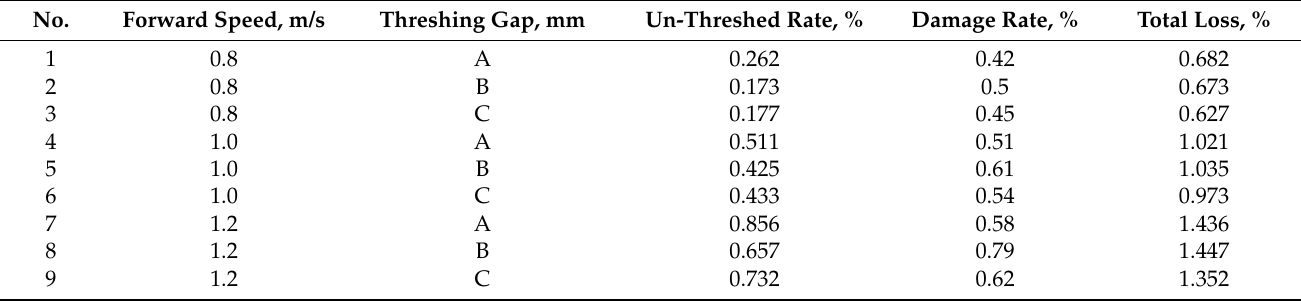
Table 9. Field test